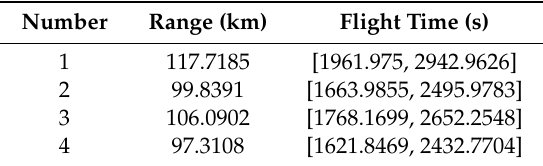
Table 14. Range and flight time of each aircraft (case 3).